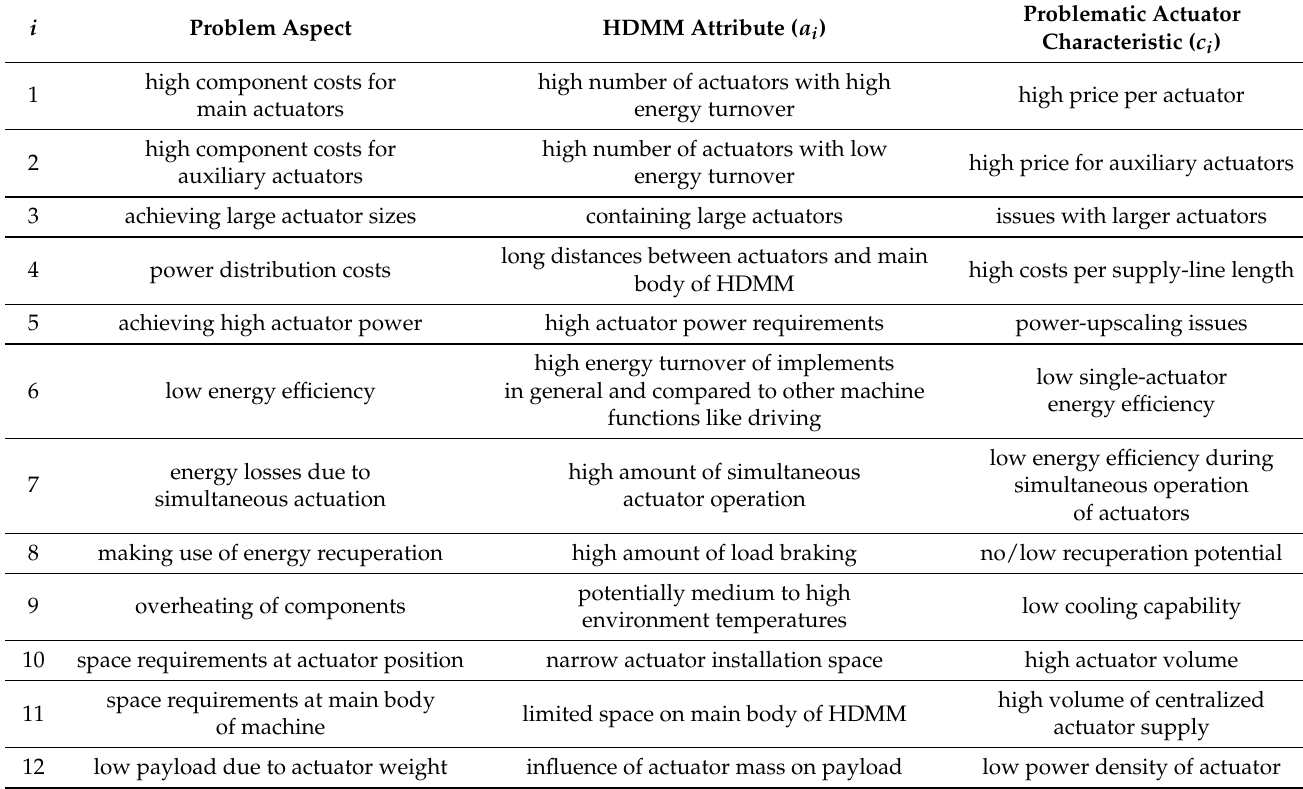
Table 1. Considered problem aspects for the match